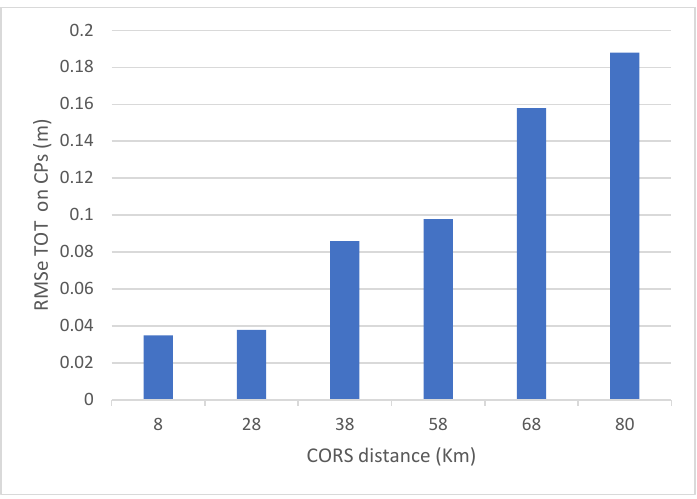
Figure 5. RMSE TOT of CPs for configuration from PPK_10 to PPK_15.